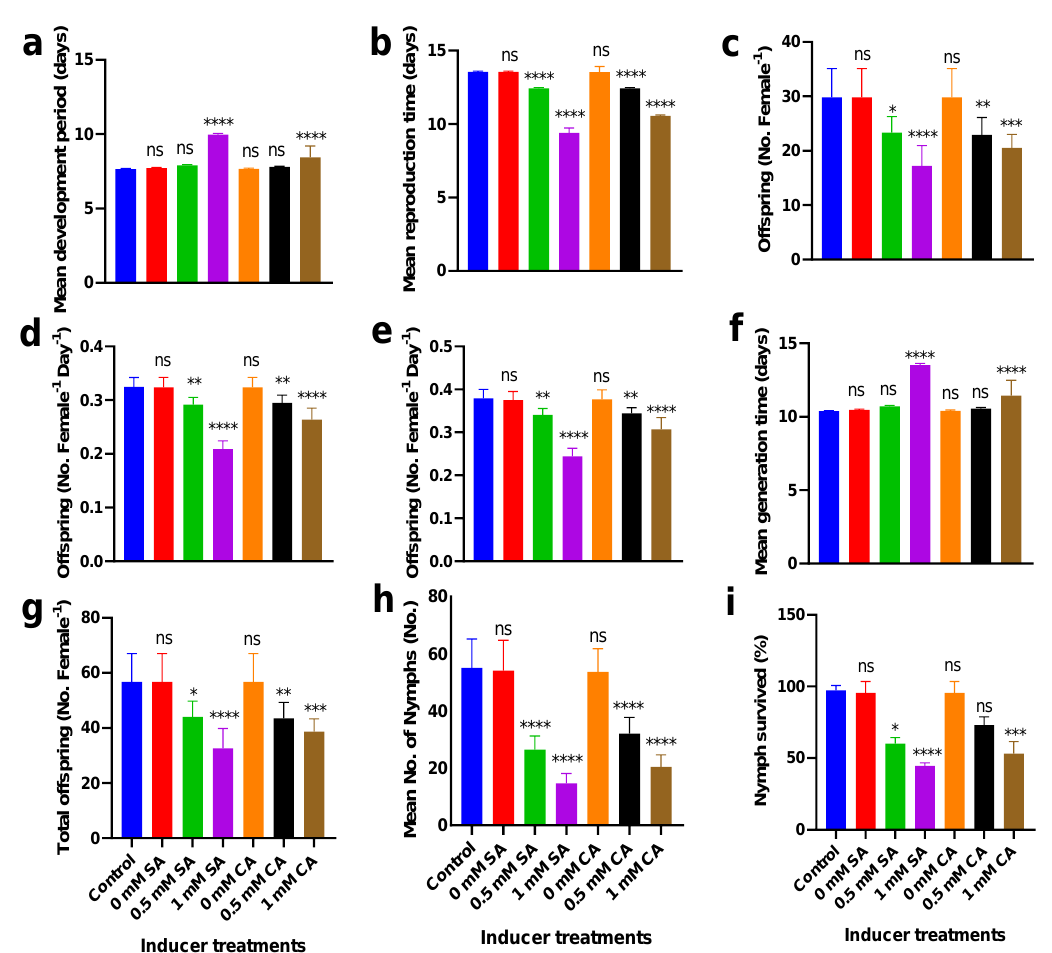
Figure 2. Effects of SA (Salicylic Acid) and CA (Citric Acid) on different fitness attributes of Brevicoryne brassicae (Mean ± SD, n = 10). ( a ) Development period (Days). ( b ) Reproduction time (Days). ( c ) Effective fecundity (No. Female Day − 1 ). ( d ) Intrinsic rate of natural increase (No. Female − 1 Day − 1 ). ( e ) Relative growth rate (No. Female − 1 Day − 1 ). ( f ) Generation time (Days). ( g ) Total progeny production (No. Female − 1 ). ( h ) Immature becoming adults (No Female.). ( i ) Progeny nymph survival (%). Statistical significance of P in post hoc tests: ns ≥ 0.05, * <0.05, ** <0.01, *** <0.001, ****